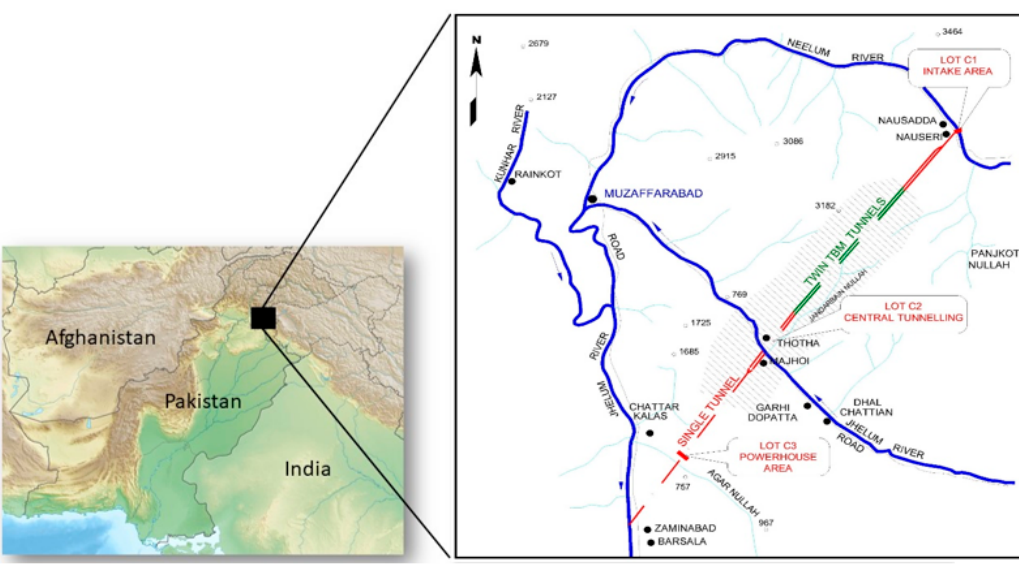
Figure 1. Location map of the Neelum Jhelum Hydroelectric Project (NJHEP) (without scale). Energies 2019 , 12 , x